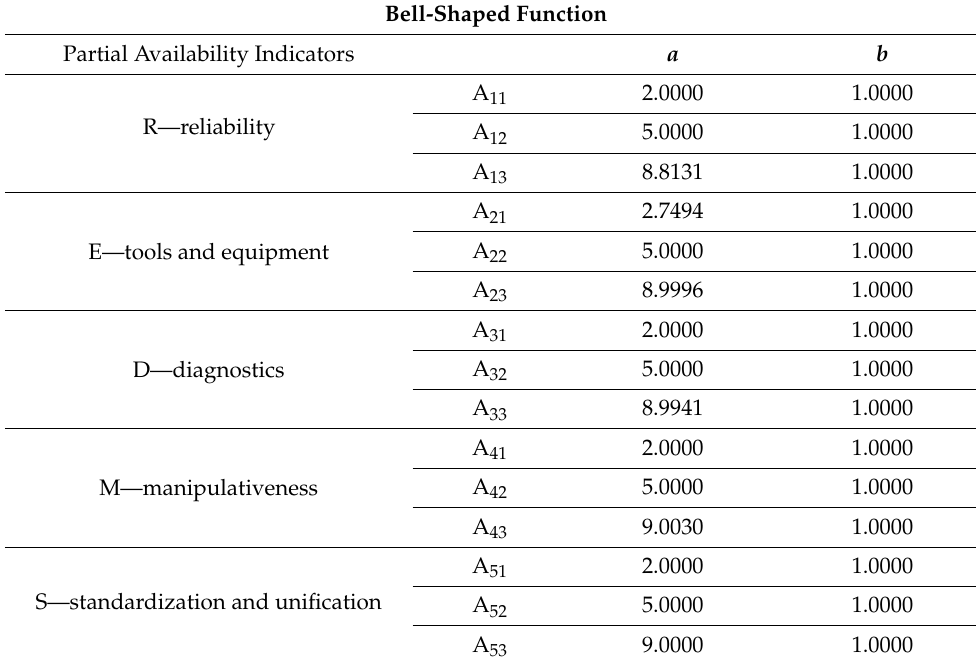
Table 5. Evaluation parameters of partial indicators for the bell-shaped